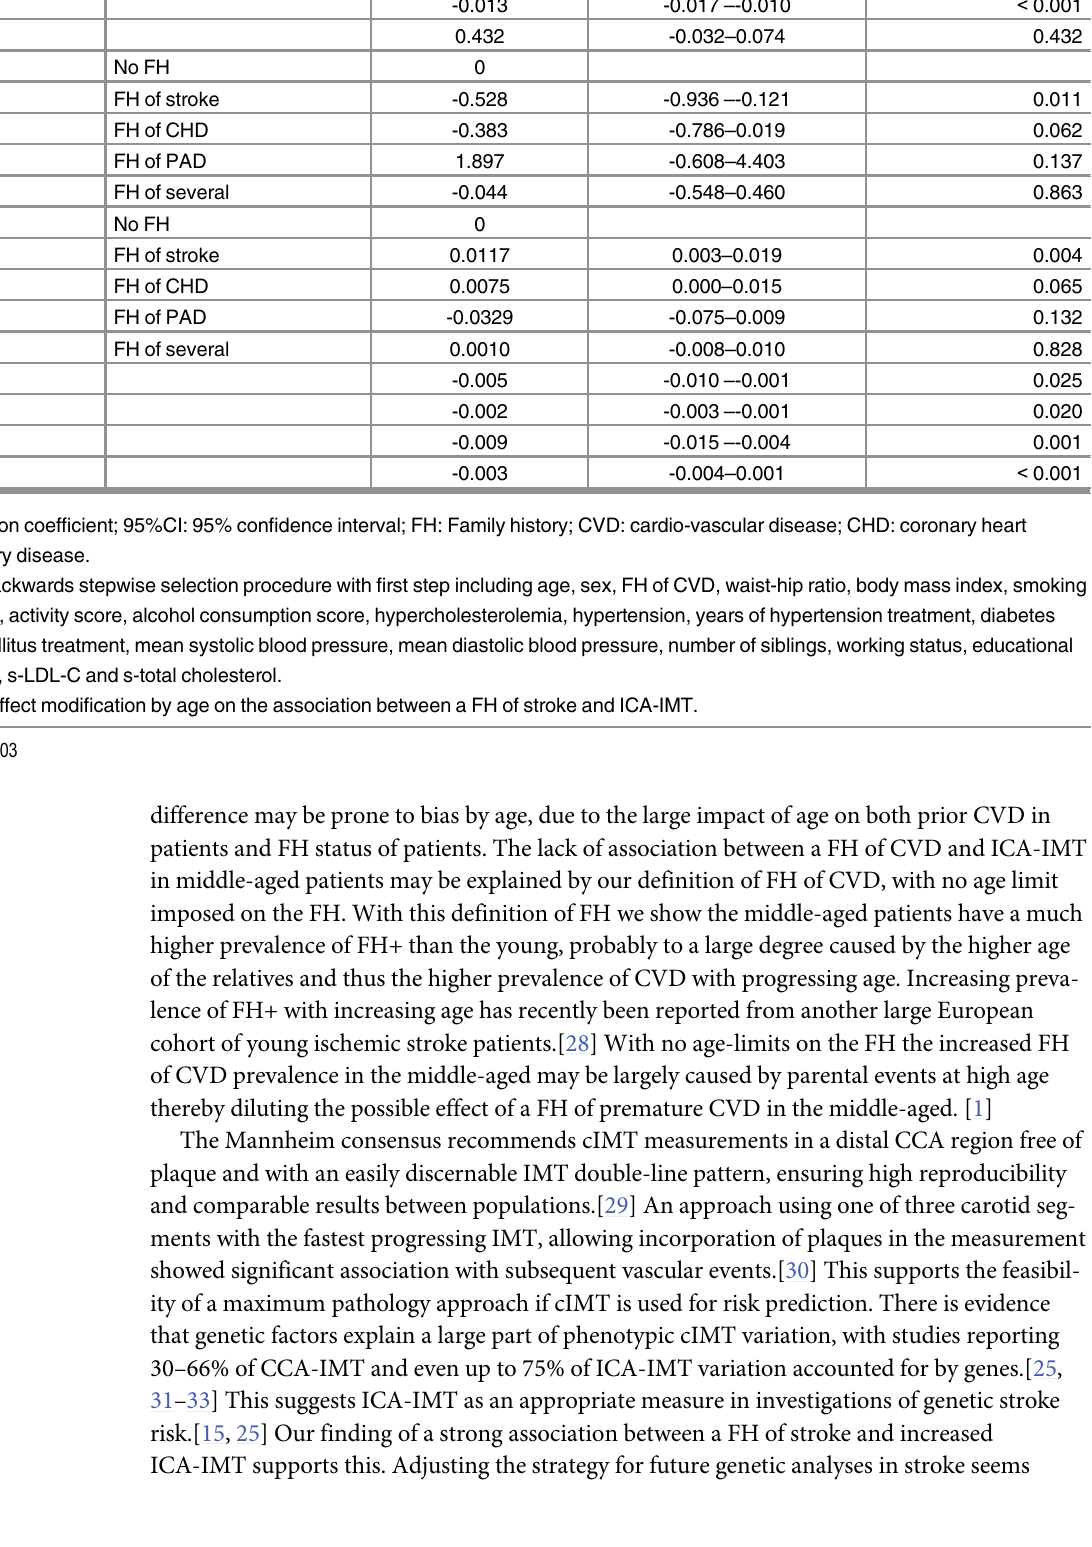
Table 3. Multiple linear regression analysis displaying factors associated with the transformed internal carotid artery-intima media thickness (1/ p ICA-IMT) in 382 ischemic stroke patients aged 15-60y included in the Norwegian Stroke in Young Study (NOR-SYS) Bergen, Norway 2010 – 2015. Variable a